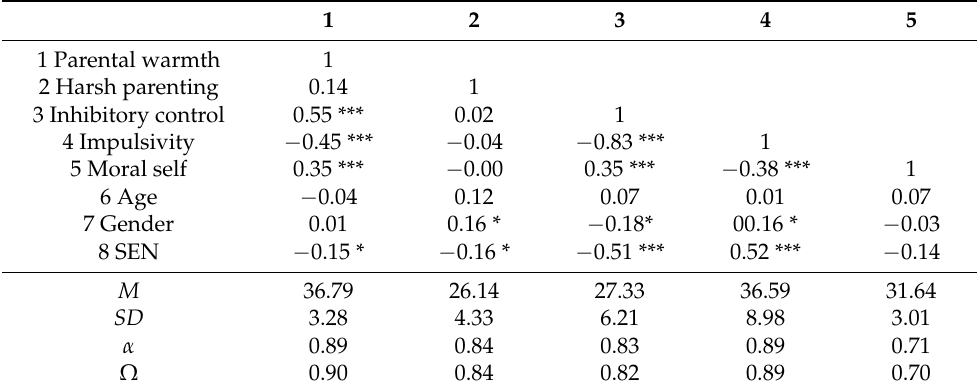
Table 1. Intercorrelations, means, standard deviations and reliability.